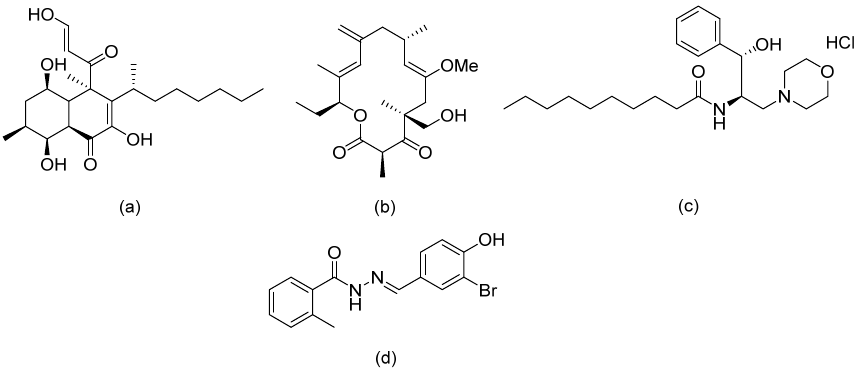
Figure 18. The chemical structures of ( a ) australifungin, ( b ) galbonolide A, ( c ) D-threo-PDMP, and ( d ) BHBM.